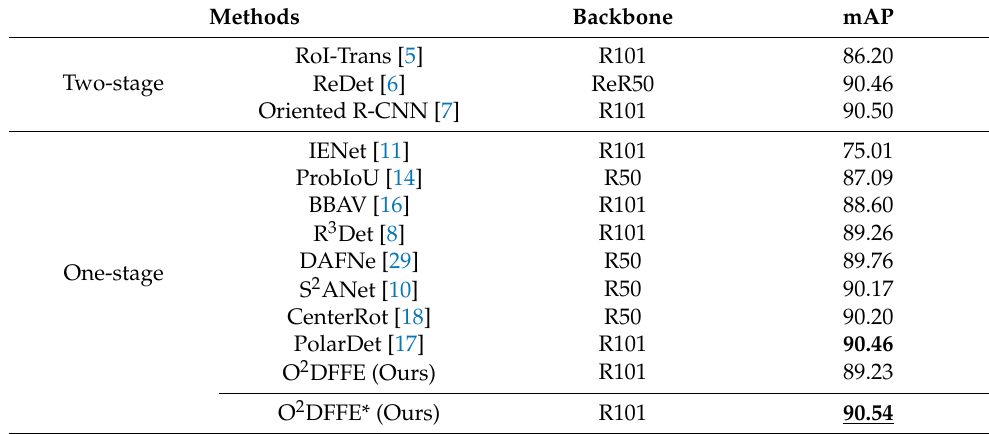
Table 3. Evaluation results on HRSC2016 datasets. R50 denotes ResNet50. R101 denotes ResNet101. ReR50 denotes ReResNet50. * denotes multiscale training and multiscale testing. Bold and underlined data denotes best performance. Bold data denotes second best